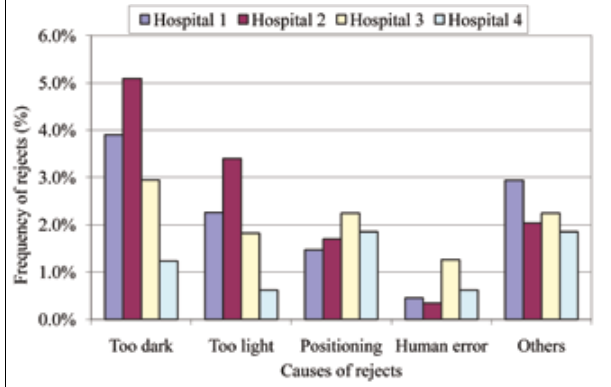
Fig. 2. Causes of film rejects per